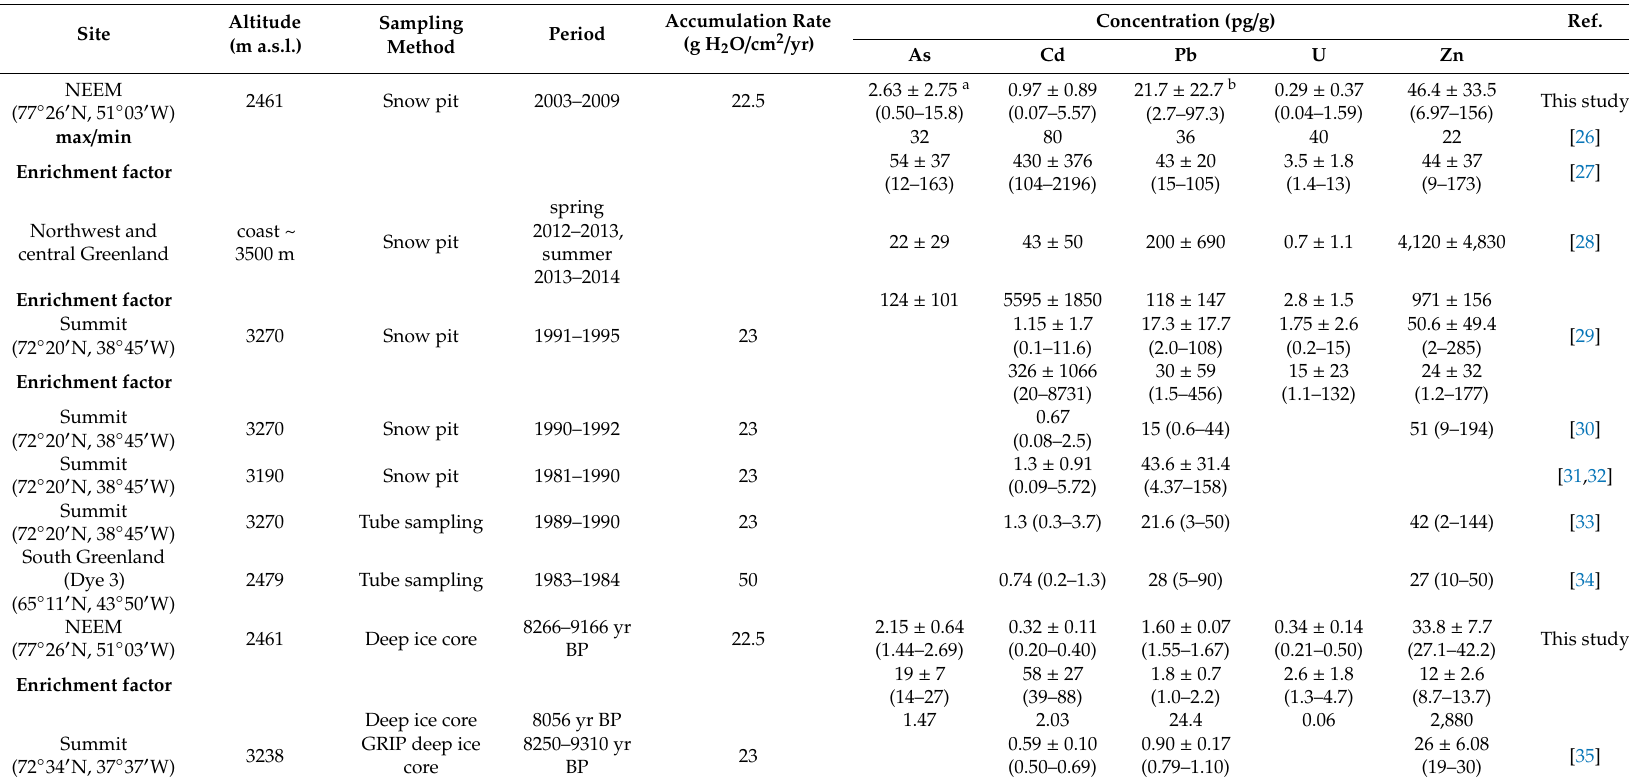
Table 2. Statistical summary of mean values (expressed as mean ± SD) and ranges (min–max in parentheses) of elemental concentrations and crustal enrichment factors (EFs) in our snow and ice samples and comparison with published data obtained from Greenland snow and